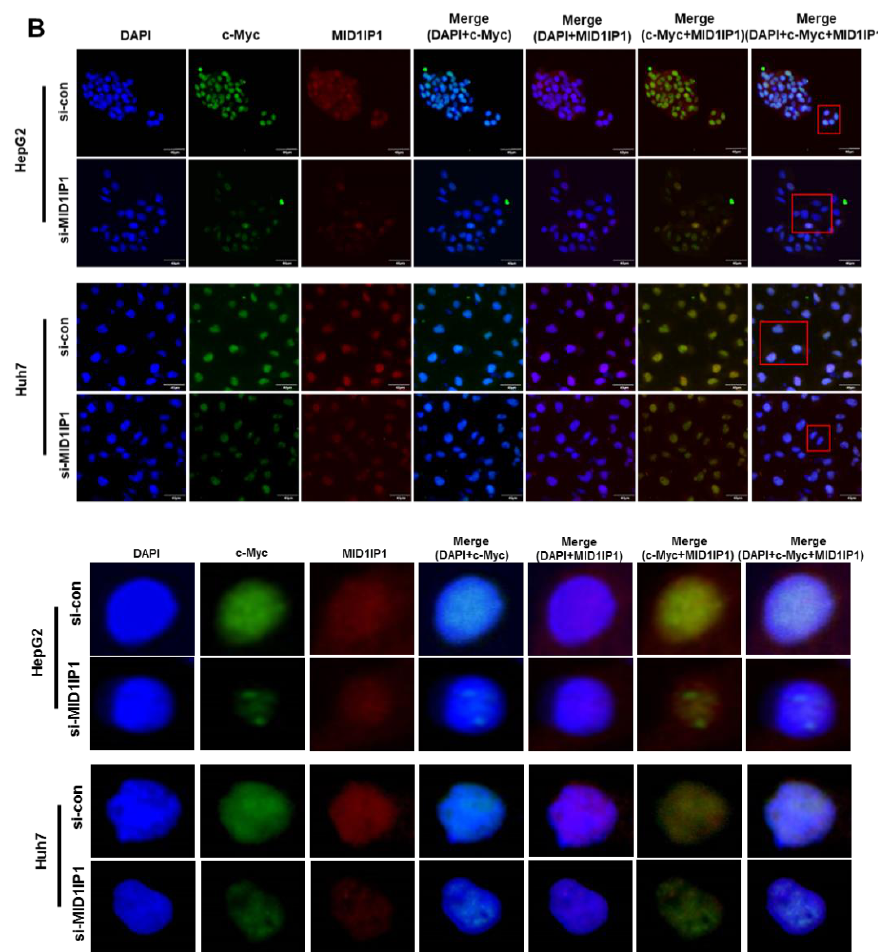
Figure 5. Colocalization between MID1IP1 and c-Myc in human HCC tissues, HepG2 and Huh7 cells. ( A ) Human HCC patient tissue microarray (two slides) purchased from Biomax (HLivH160CS01, USA) was subjected to immunohistochemistry (IHC) staining by Discovery XT IHC/ISH Research Platform (Roche, Germany). Expression level of MID1IP1 and c-Myc each of HCC tissues (62) and normal tissues (34) with correlation coefficient. ( B ) HepG2 and Huh7 cells transfected with MID1IP1 siRNA or negative control siRNA were cultured for 72 h and then were subjected to Immunoflourescence with antibodies of MID1IP1, c-Myc, Alex Fluor 488 goat rabbit IgG antibody (Invitrogen) and Alexa Fluor 546 goat mouse-IgG antibody and DAPI. ‘D’ indicates DAPI. 3.6. The Critical Role of Ribosomal Protein L5 or L11 in c-Myc Inhibition by MID1IP1 Depletion in HepG2